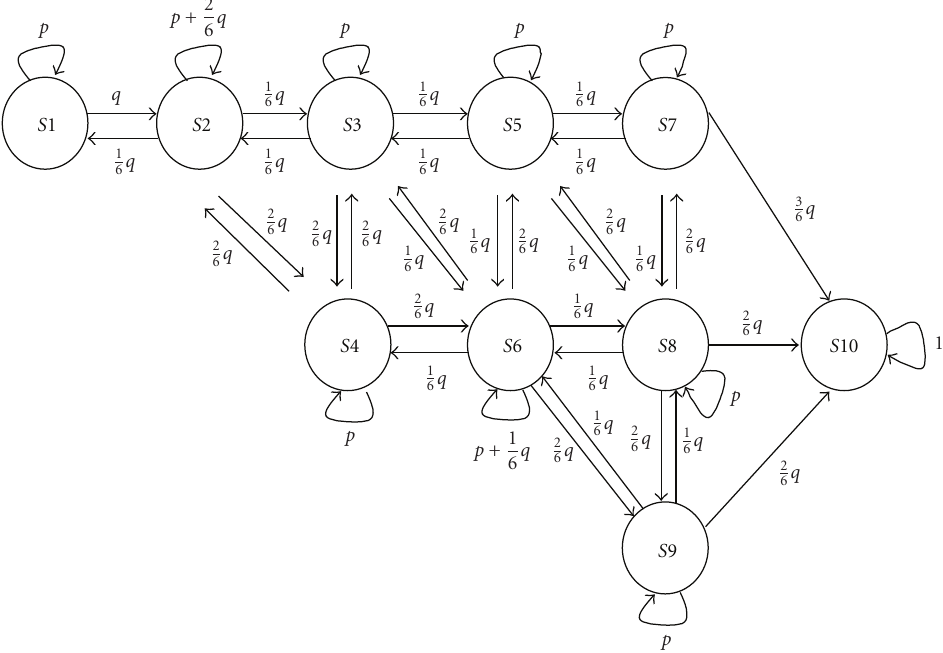
Figure 7: Markov Chain